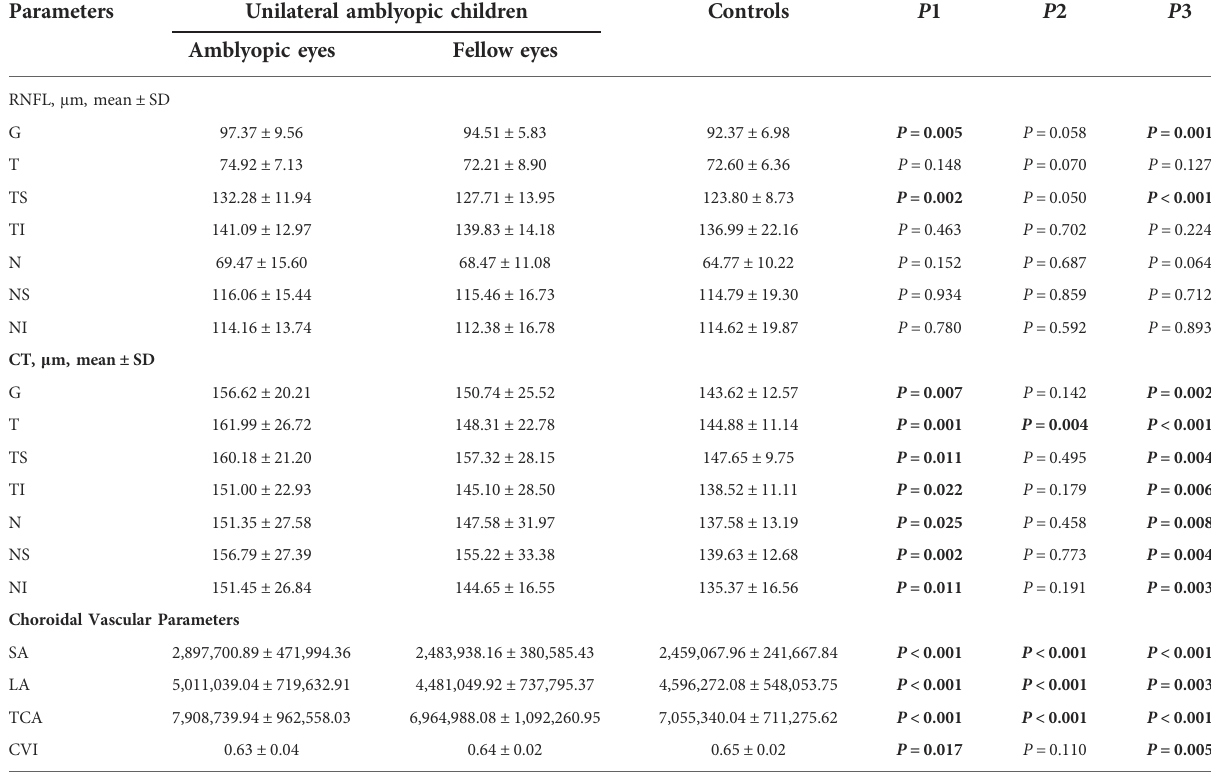
TABLE 3 Peripapillary RNFL thickness and choroidal parameters in the three